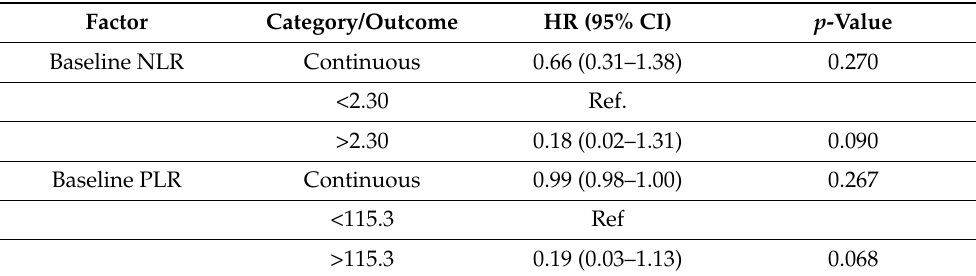
Table 10. Multivariable analysis of association between pre-operative NLR and PLR with major